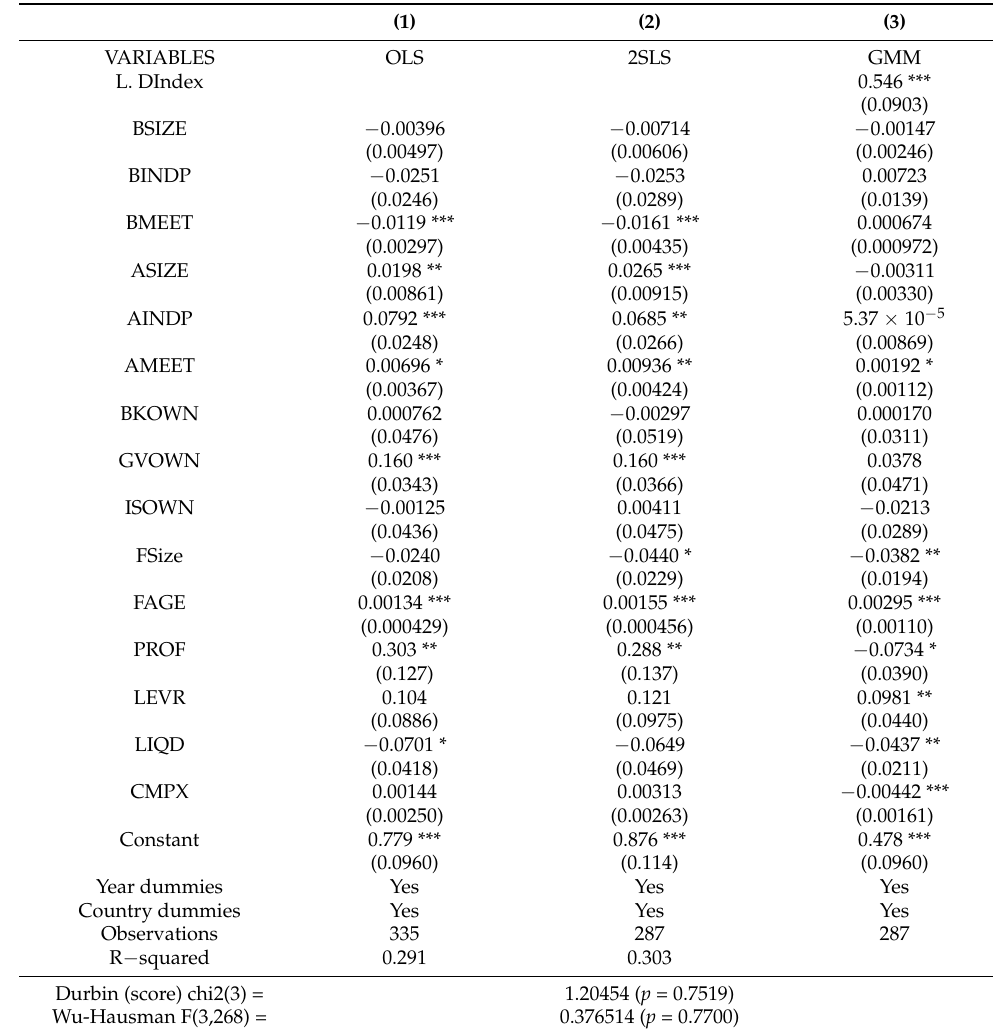
Table 6. Regression results of full